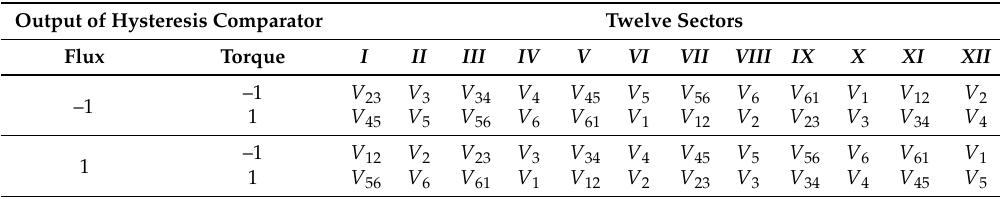
Table 4. Twelve sectors voltage vector switch table (generating mode).